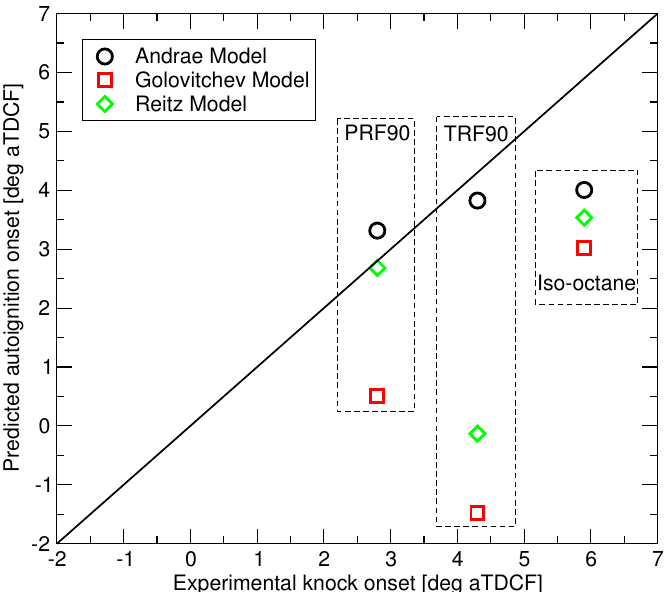
Figure 8. Predicted vs. measured autoignition onset for the three surrogate